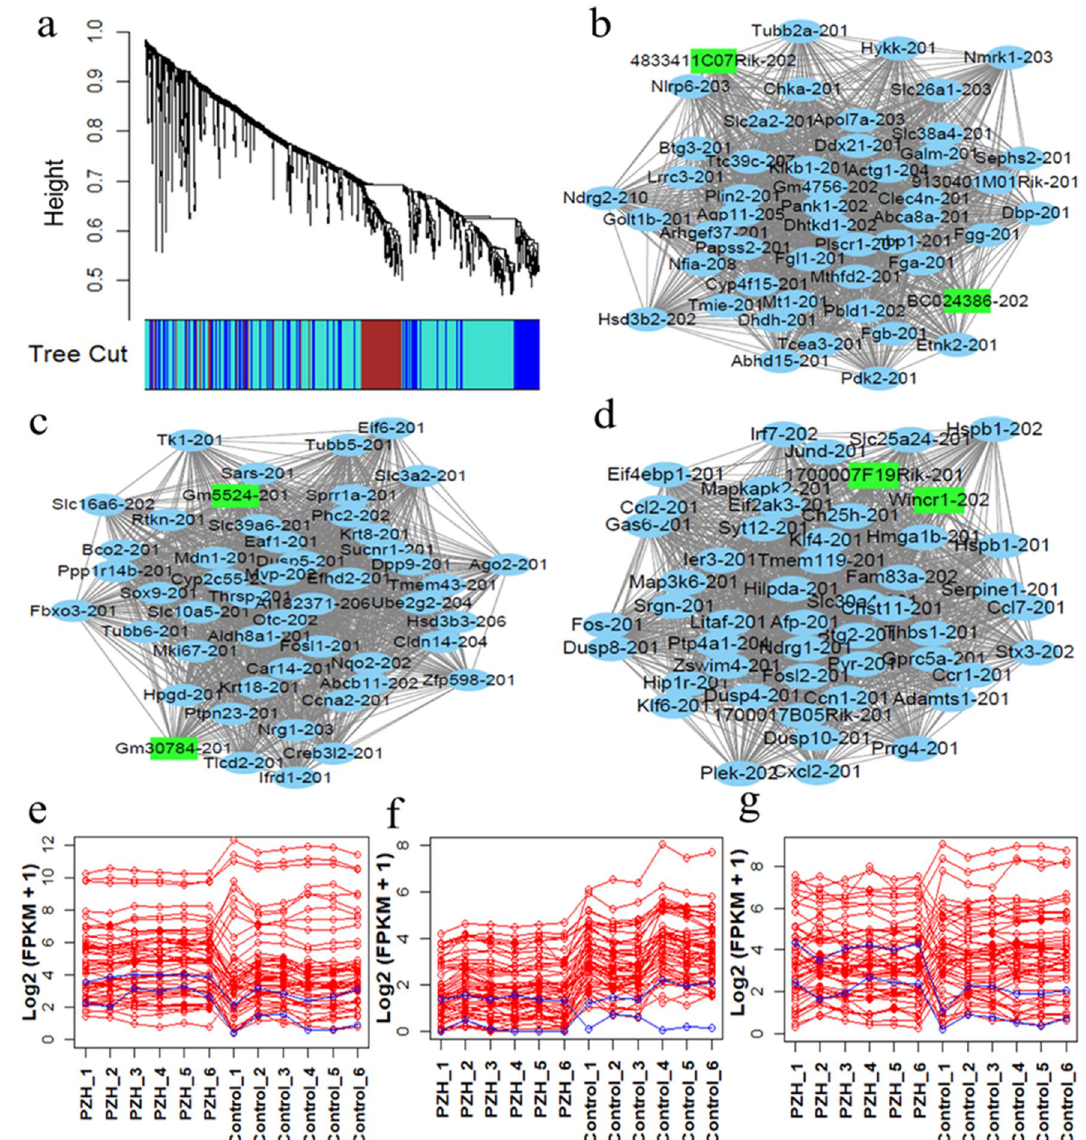
Figure 6. Co-expression network of the differentially expressed lncRNA and protein-coding transcripts. ( a ) Visualization of the co-expression modules of all the differentially expressed lncRNA and protein-coding transcripts; each color represents one module. ( b – d ) Visualization of the top 50 hub transcripts in the blue, brown and turquoise modules. The green nodes represent lncRNA transcripts, and the blue nodes represent protein-coding transcripts. ( e – g ) Expression patterns of the top 50 hub transcripts in each module. The x-axis indicates the names of each sample, and the y-axis indicates the expression log 2 (FPKM + 1) value. The blue lines represent differentially expressed lncRNA transcripts, and the green lines represent differentially expressed protein-coding interacted with the differentially expressed protein-coding transcripts. The expression pattern of each of the top 50 transcripts of the three modules is shown in Fig. 6e–g. The expression pattern results revealed that these differentially expressed lncRNA transcripts were co-expressed with the differentially expressed protein-coding transcripts. The absolute correlation values of the top 50 hub transcripts of the blue, brown and turquoise modules were 0.91 ~ 1.0, 0.90 ~ 1.0 and 0.93 ~ 1.0, respectively. Differentially expressed proteins (DEPs) involve in immune system process. We detected the protein expression using mass spectrometry sequencing based on the liver tissues of 6 treatment mice using PZH and 6 mice without any treatment of CCl 4 -induced mice model at the time point of eighth week, and 138 DEPs were identified (Fig. 7a and Supplementary Table 7). Function enrichment analysis showed that immune system biological process were significantly enriched based on the 138 DEPs ( P = 3.52 × 10 –4 ), and this biological process was also significantly enriched based on DEGs of RNA-seq. Plasminogen activation and fibrinolysis biology pro-